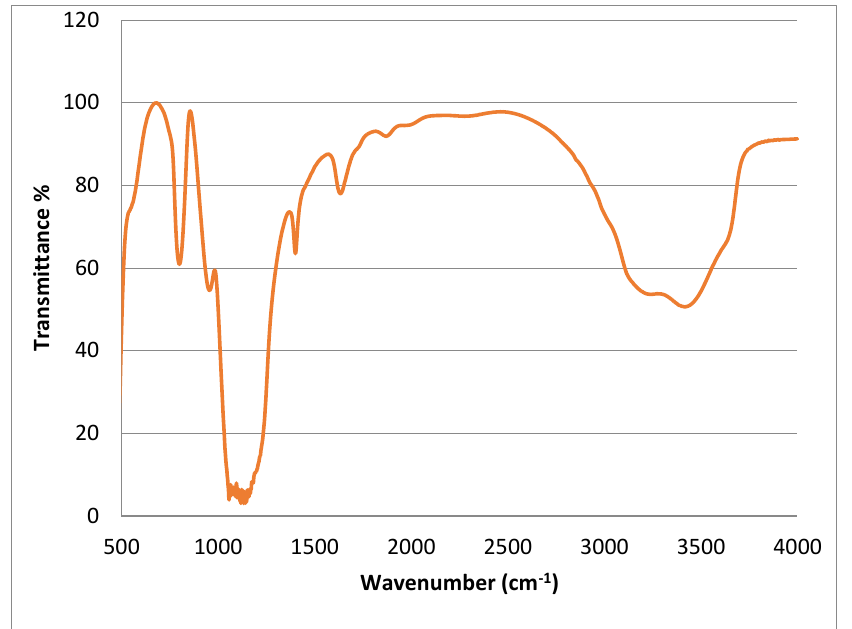
Figure 4. Fourier transform infrared (FTIR) spectroscopy of AgNPs produced with Ulvan from Ulva lactuca.